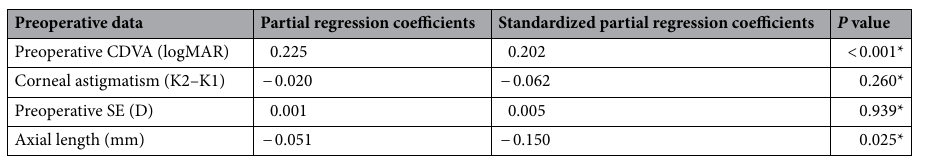
Table 5. Multivariate regression analysis of postoperative absolute refractive error and preoperative data. CDVA, corrected distance visual acuity; SE, manifest spherical equivalent. *Multivariate regression analysis.